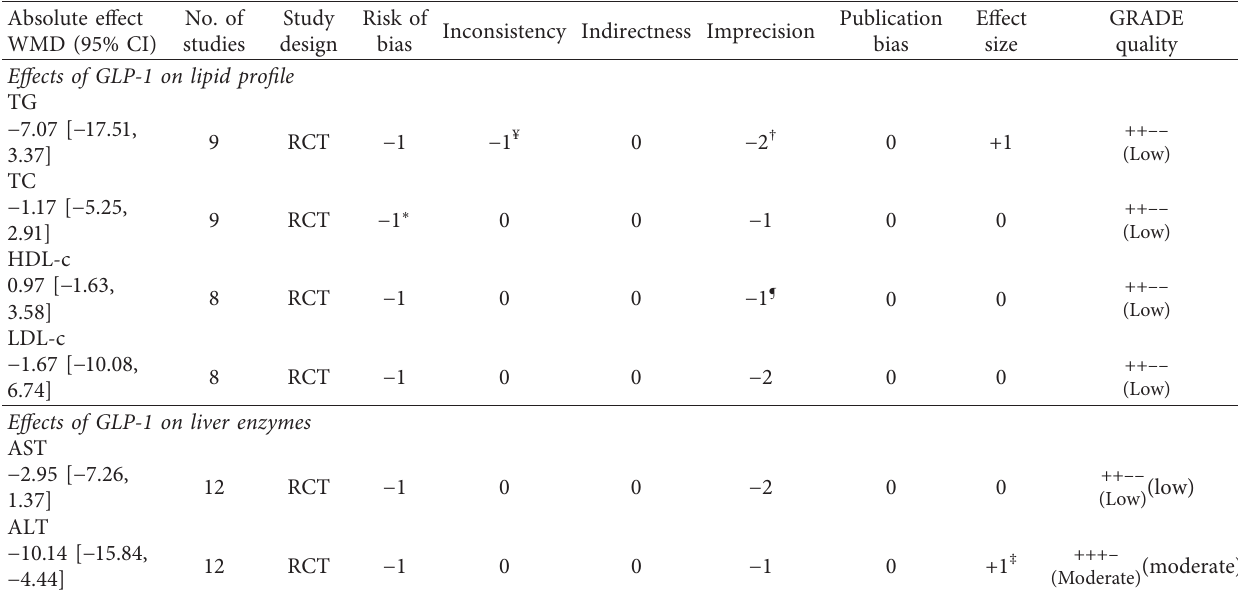
Table 2: Summary of